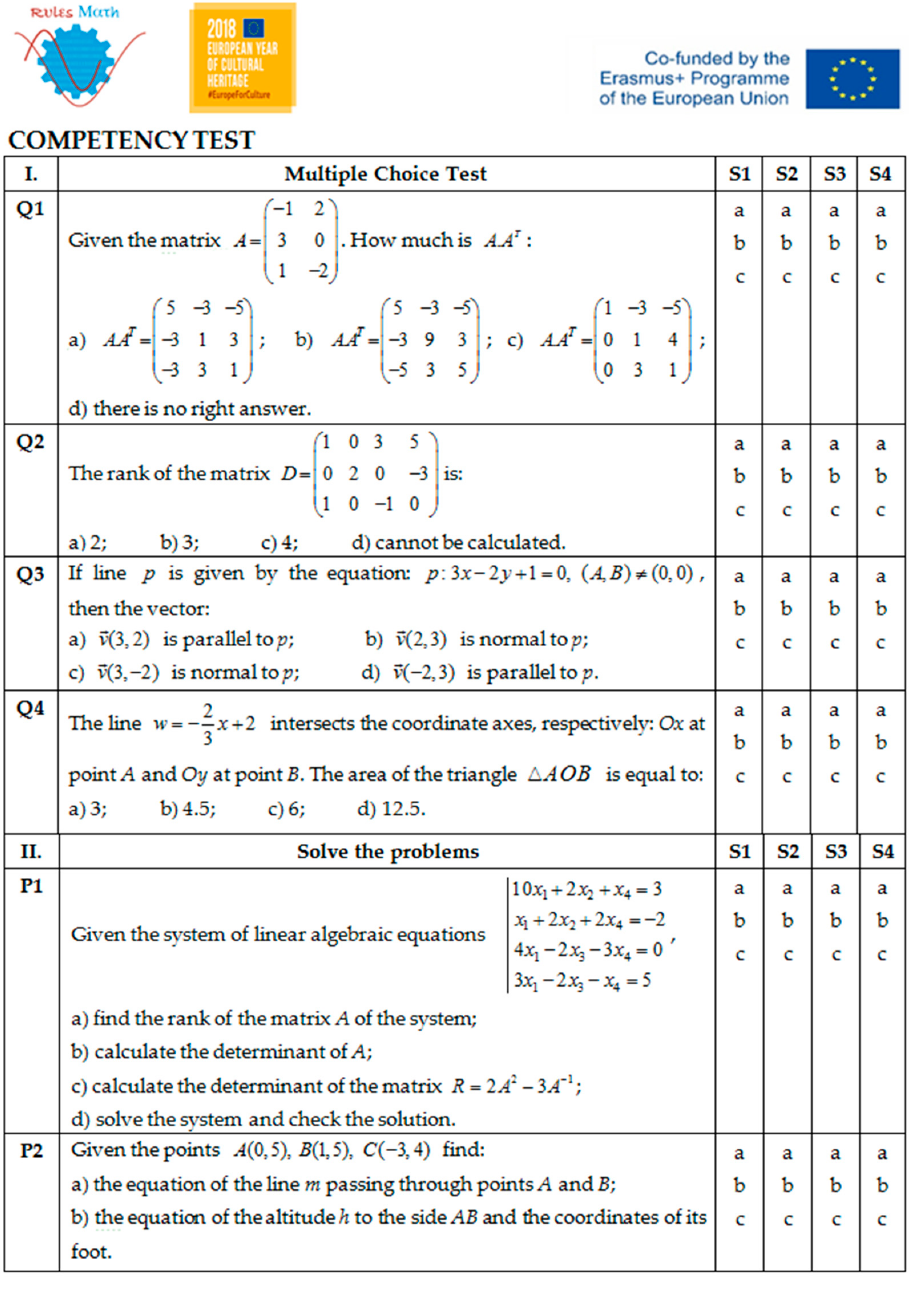
Figure 1. Sample test.